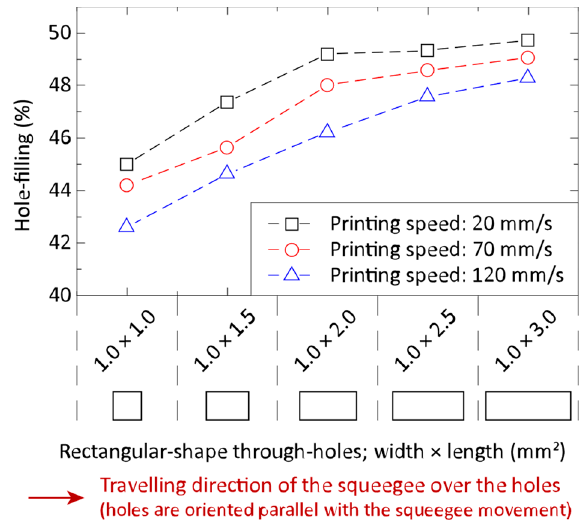
Figure 12. Hole-filling as a function of rectangular-shaped through-holes at different printing speeds (note that the dimension of the holes in z -direction was 4 mm).